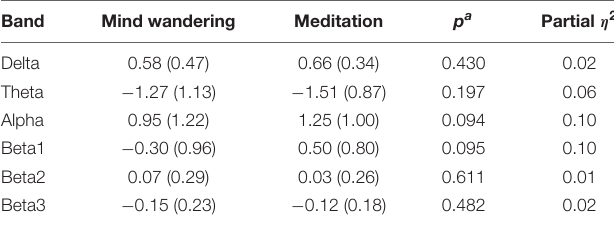
a p Values represent tests for differences between the two state